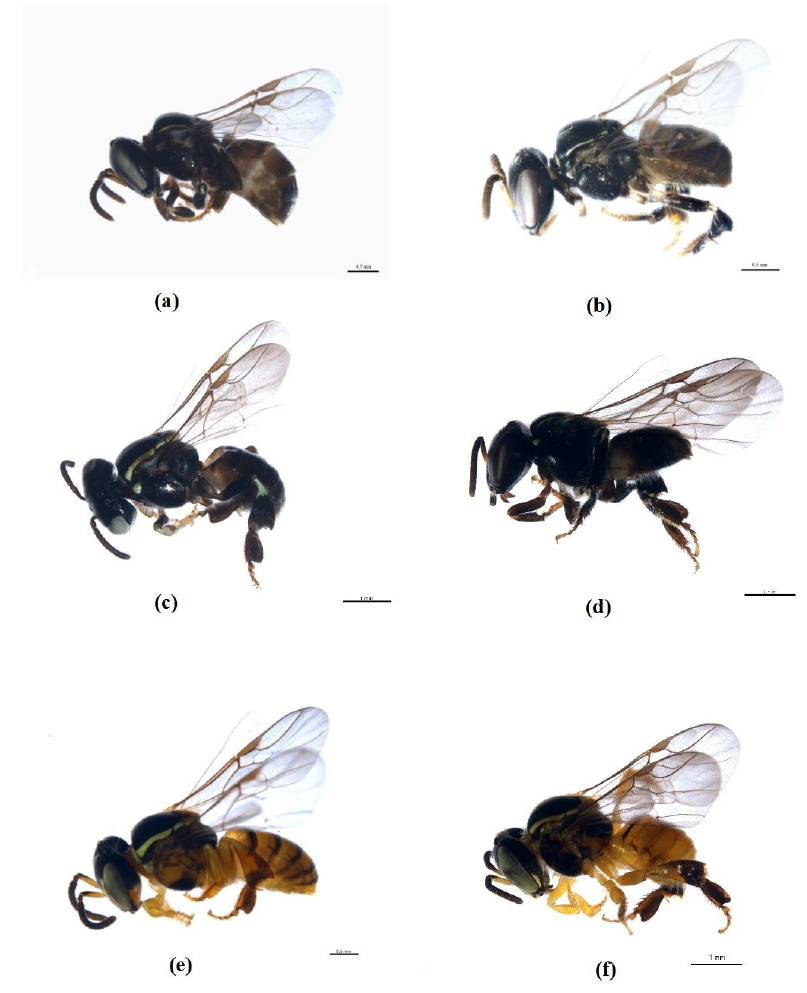
Figure 5. Specimens of Plebeia spp. ( a ) P. cf. franki Clade A (JP5), ( b ) P. cf. franki Clade B (POA32), ( c ) P. cf. frontalis Clade A (MA22-1), ( d ) P. cf. frontalis Clade B (JP31), ( e ) P. cf. frontalis Clade C (POA40), ( f ) P . cf. frontalis Clade D (UT58). Scale bar: 1 mm.